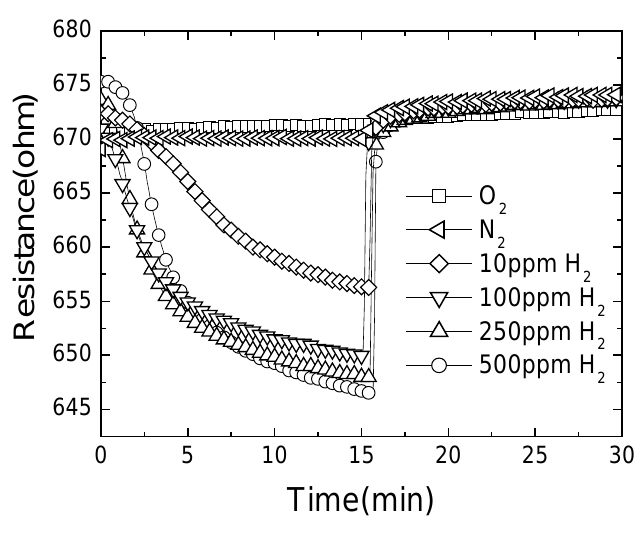
Figure 12 .Time dependence of resistance change of Pd-coated ZnO nanorods as the gas ambient is switched from N to oxygen or various concentrations of H 2